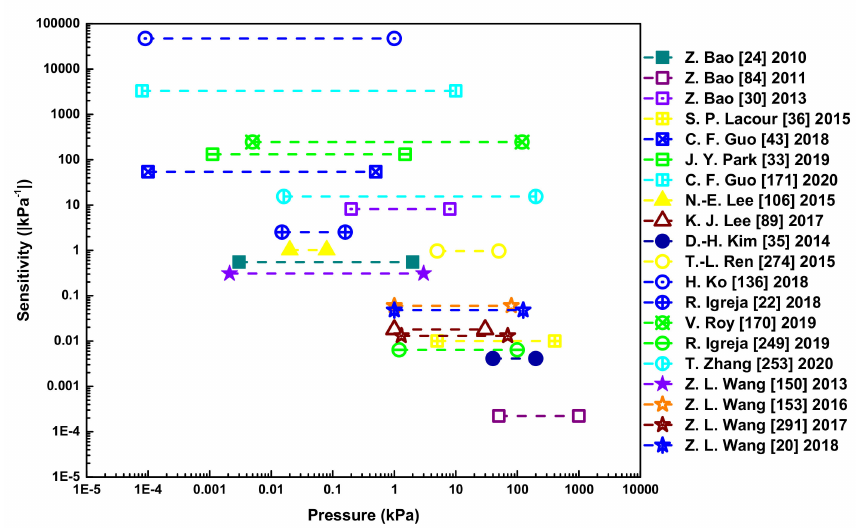
Figure 19. Sensitivity and the corresponding pressure range for which it is valid for 20 of the most cited works since